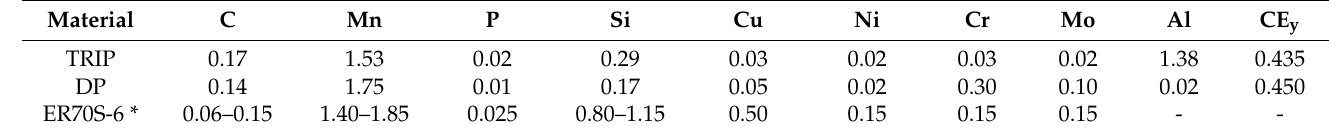
Table 1. Chemical composition (OES) of TRIP and DP steel